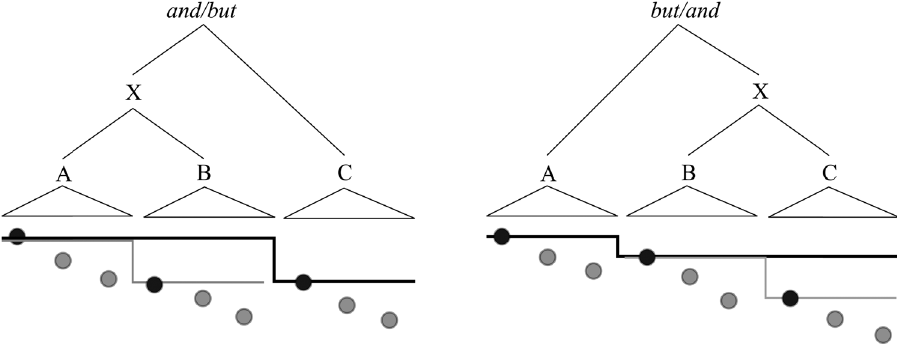
Figure 1: Pitch scaling and reset ( drawn after Truckenbrodt and Féry 2015: 22 )